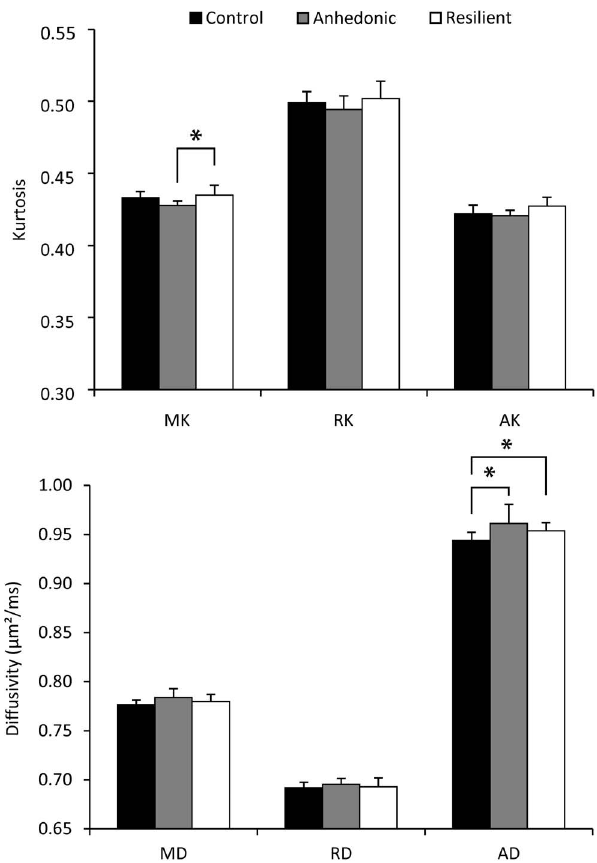
Figure 4. Results of the diffusion analysis of the amygdala. Groups mean ( 6 SD) diffusion kurtosis (top) and diffusivity (bottom) parameters of the amygdala. One-way analysis of variance followed by post hoc least significant difference tests showed a significant increase of RD in both the anhedonic-like and resilient animals as compared with the unchallenged group. *p , .05 AD, Axial diffusion; AK, axial kurtosis; MD, mean diffusion; MK, mean kurtosis; RD, radial diffusion; RK, radial